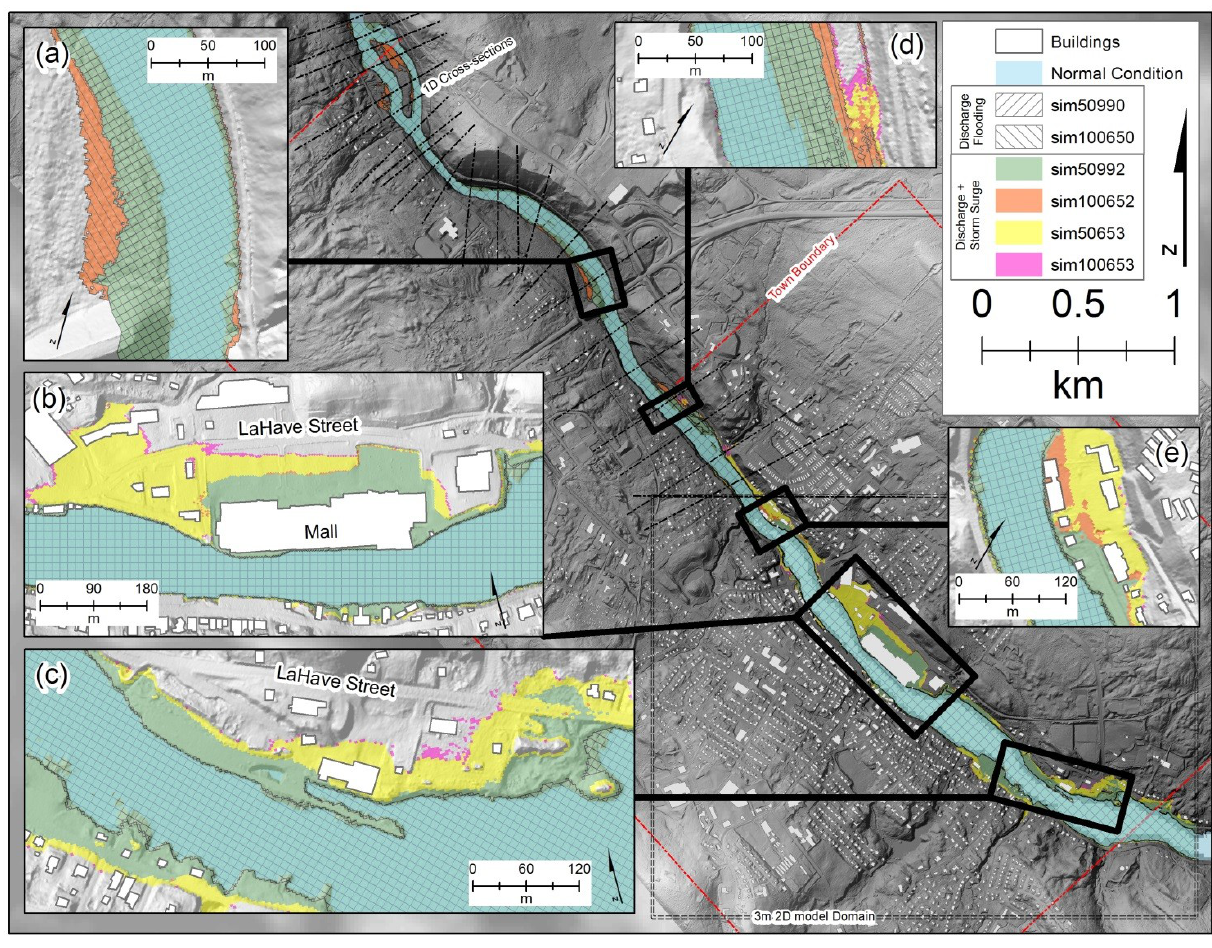
Figure 9. The various levels of flood risk for the Town of Bridgewater depicting outputs for combined 1-D and 2-D for; sim50990: 441 m 3 /s discharge event with normal high tide; sim100650: 741 m 3 /s discharge event with normal high tide; sim50992: 441 m 3 /s discharge event with a 2.2 m storm surge amplification during a normal high tide; sim100652: 741 m 3 /s discharge event with a 2.2 m storm surge amplification during a normal high tide; sim50653: 652 m 3 /s discharge event with a 3.5 m storm surge amplification during a normal high tide; sim100653: 741 m 3 /s discharge event with a 3.5 m storm surge amplification during a normal high tide (See Table